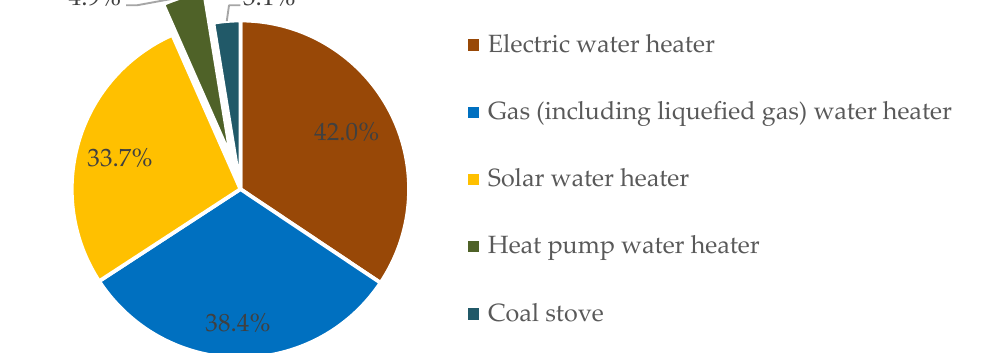
Figure 2. Water-burning equipment for families of respondents. Table 3. Influence of demographic information of respondents on purchase intention for